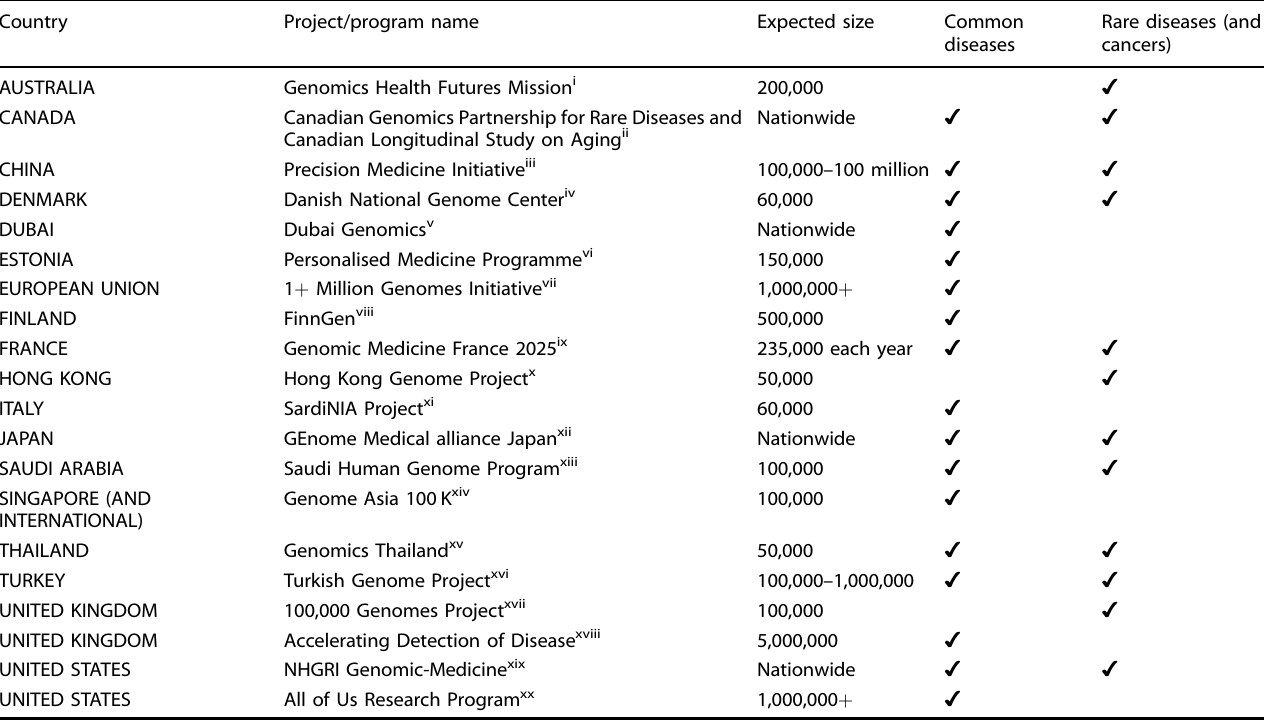
Table 1. Precision medicine